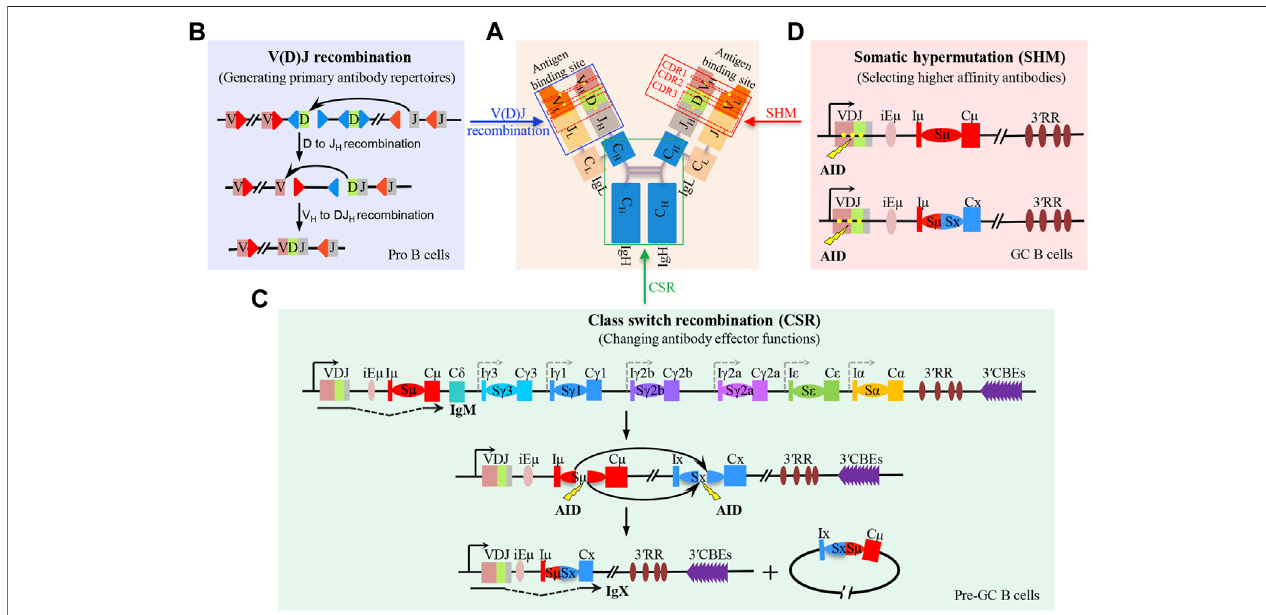
FIGURE1| V(D)Jrecombination,classswitchrecombination,andV(D)Jexonsomatichypermutation-mediatedantibodydiversi fi cation. (A) Schematicstructureof antibody which is composed of two pairs of immunoglobulin heavy (IgH) and light (IgL) chains. The blue box indicates the antibody variable region which binds to antigens.Thegreenboxindicatestheantibodyconstantregion,wheretheclassswitchrecombinationoccurs.TheredboxindicatesthemutatedregionincludingCDR1, CDR2, and CDR3 within the V(D)J exon; the yellow dots indicate the mutation sites. (B) Two-step process of RAG-initiated V(D)J recombination in progenitor (pro) B cells. (C) Process of AID-initiated class switch recombination (CSR) in mature B cells before entering the germinal center (GC), termed as pre-GC cells. (D) Process of AID-initiated V(D)J exon somatic hypermutation (SHM) in non-switched and switched GC B cells.